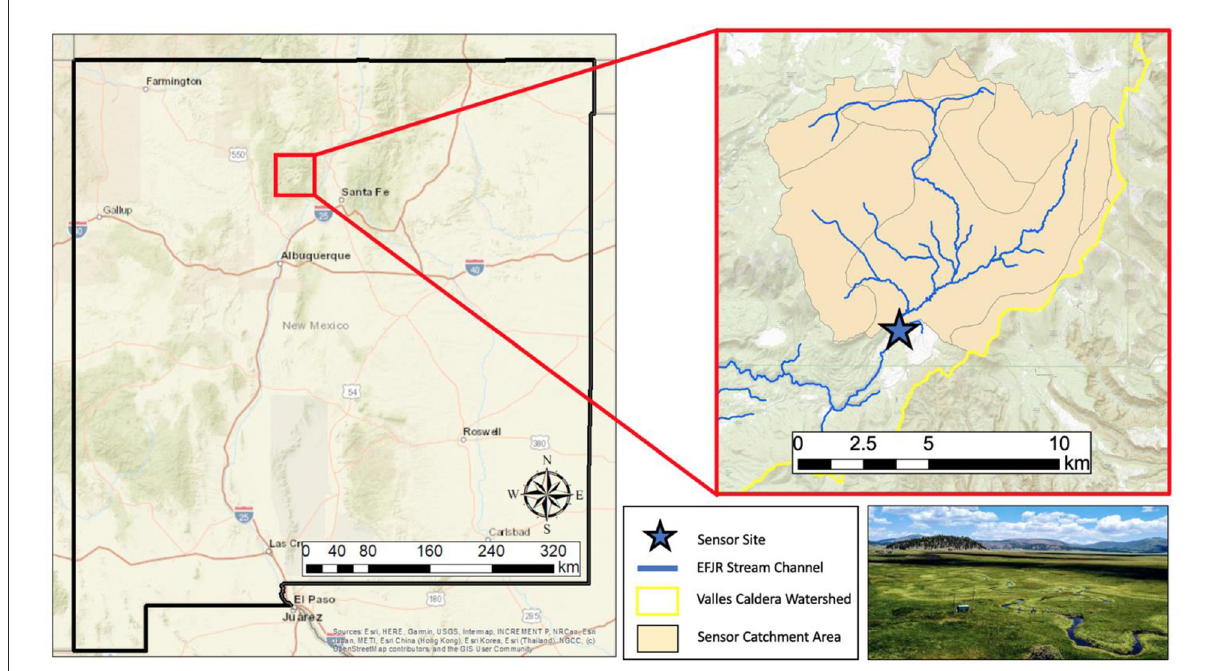
FIGURE1 Map and picture of the East Fork Jemez River watershed, located in the Valles Caldera National Preserve in north central New Mexico (USA). Maps were created in Esri ArcMap 10.8.2.